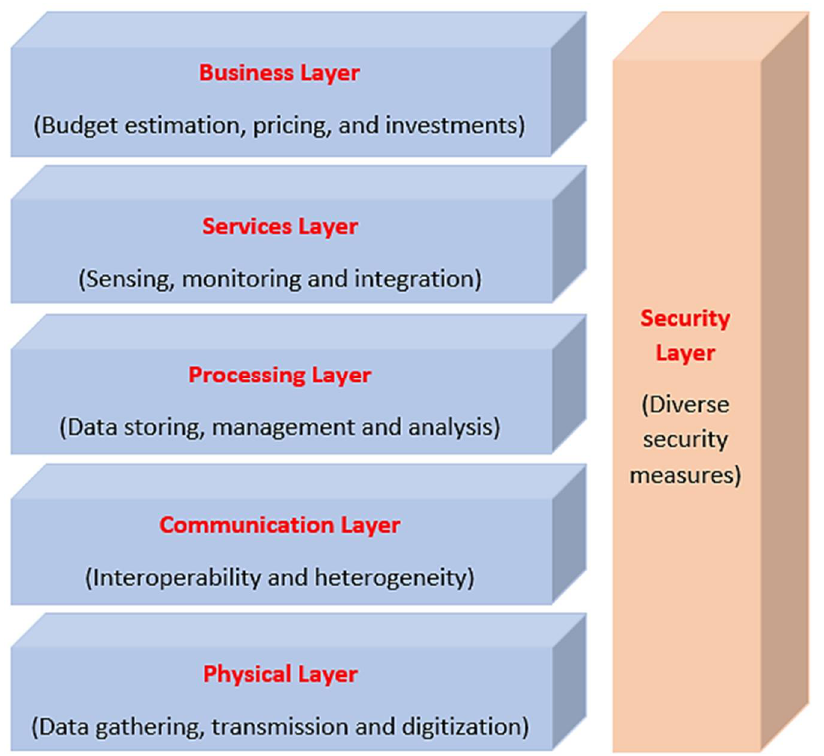
Figure 2. The proposed six-layers architecture of IoV.